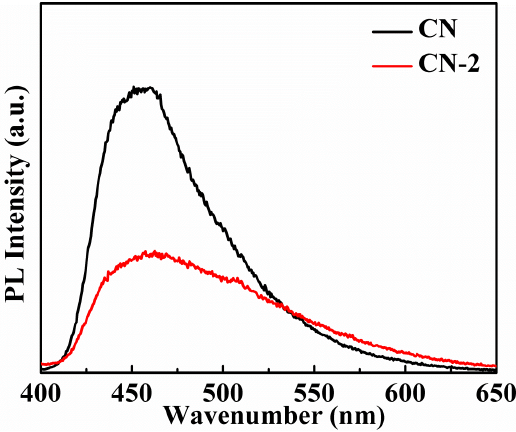
Figure 5. PL spectra of CN and CN-2 (325 nm excitation).